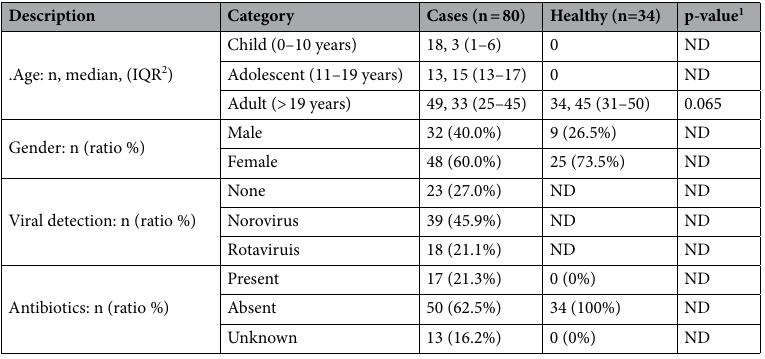
Table 1. Clinical and demographic characteristics. 1 Statistical comparison between healthy controls